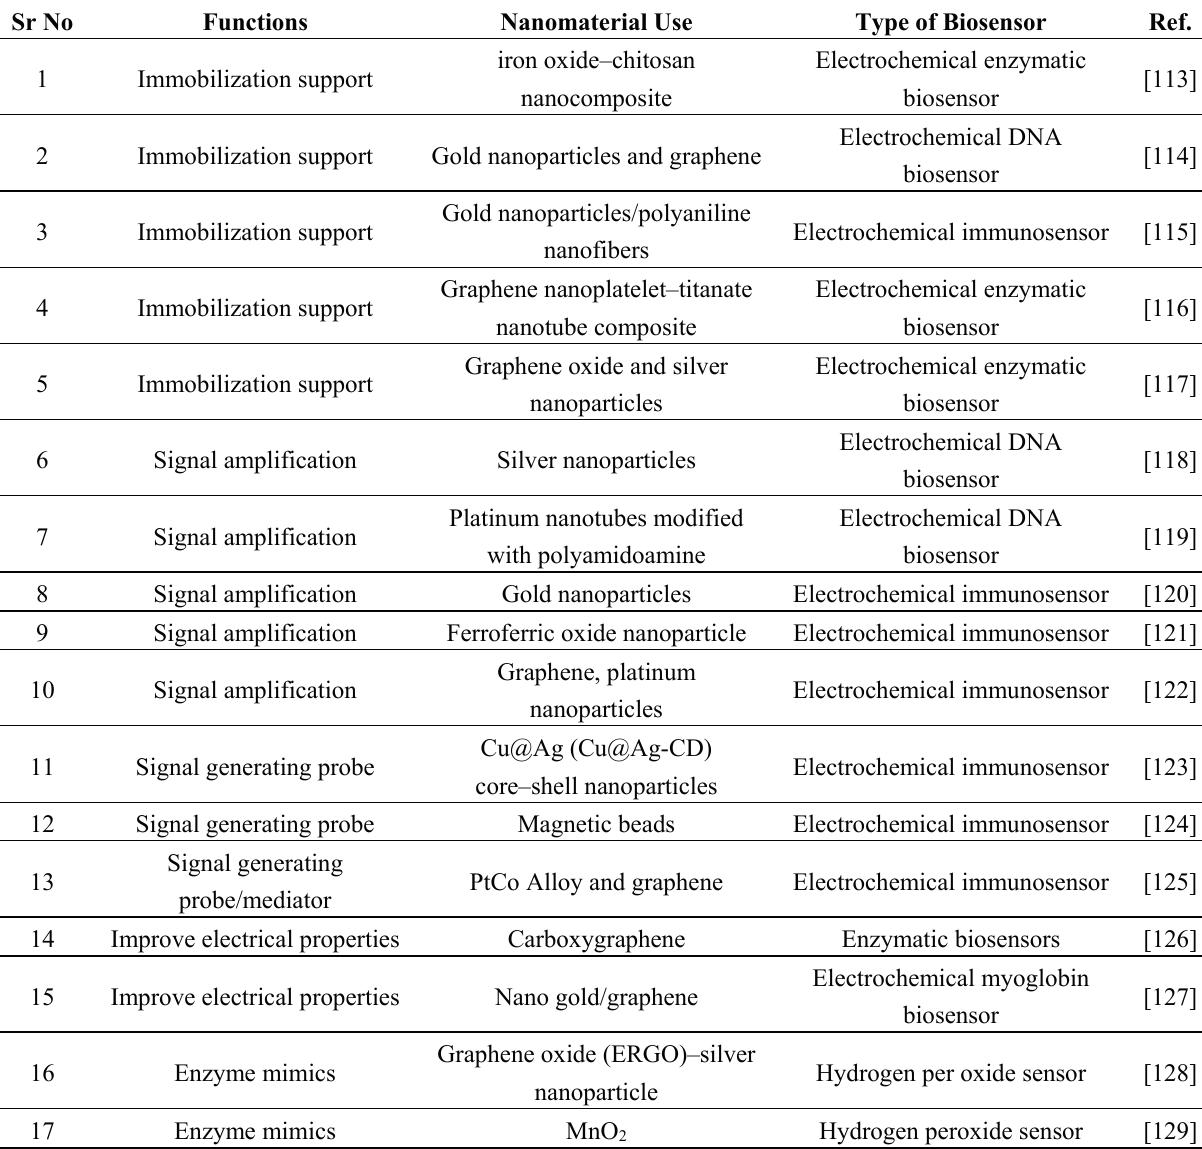
Table 1. Some of the examples of nanomaterials functions in electrochemical biosensors. Sr No Functions Nanomaterial Use Type of Biosensor